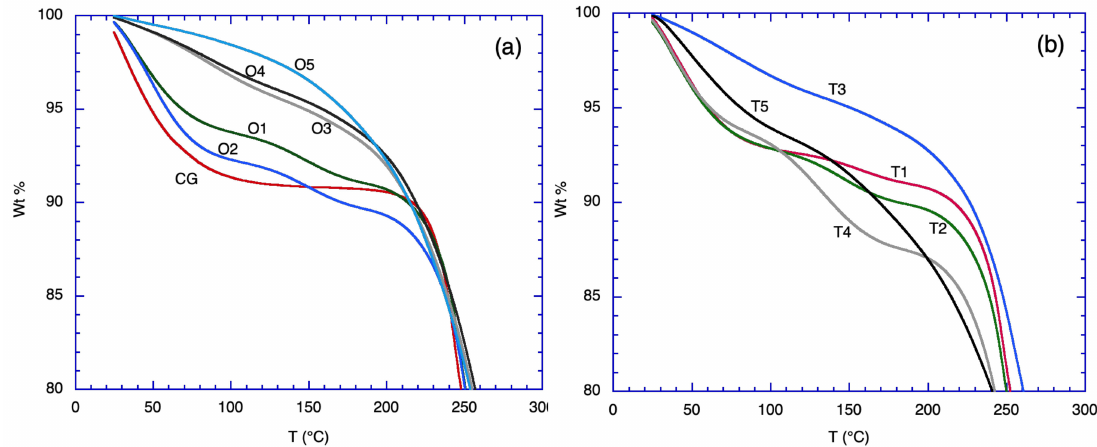
Figure 7. TGA data for CG–OSA adducts (left) and CG–TPSA adducts (right). Sample numbers are the same as given in Table